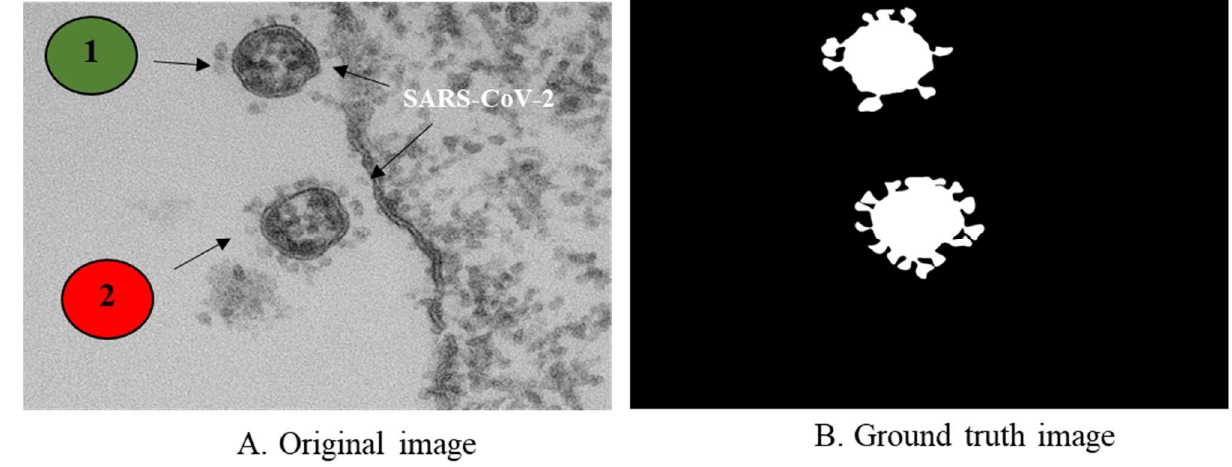
Figure 5. Illustration of morphometry of SARS-CoV-2 virus image: A . original image B . ground truth image.